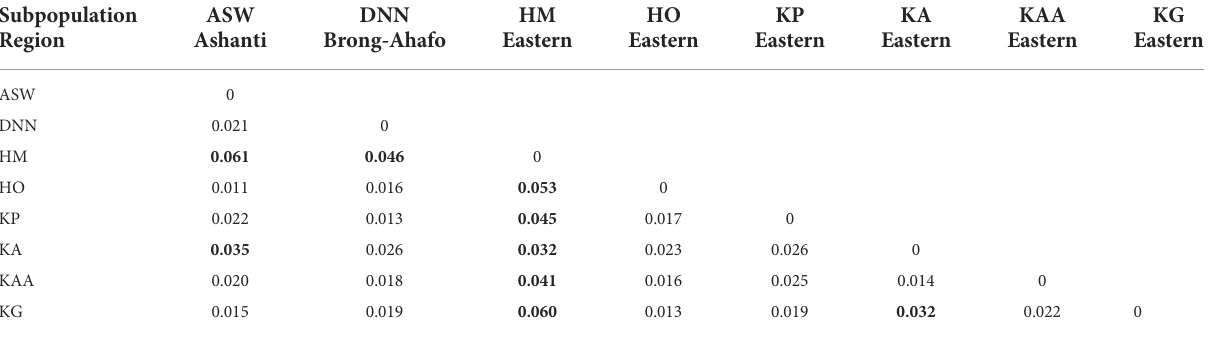
F ST values (Table 4) except for Kwahu-Abene and Krobo Gyekiti subpopulation from the eastern region.